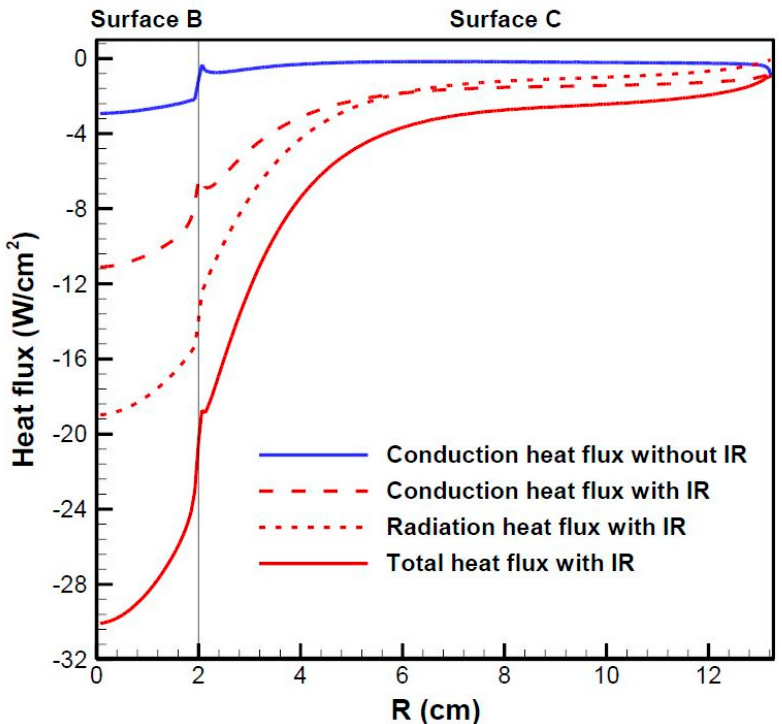
Figure 3. Heat flux distributions along the bottom surfaces of the crystal without and with internal radiation.